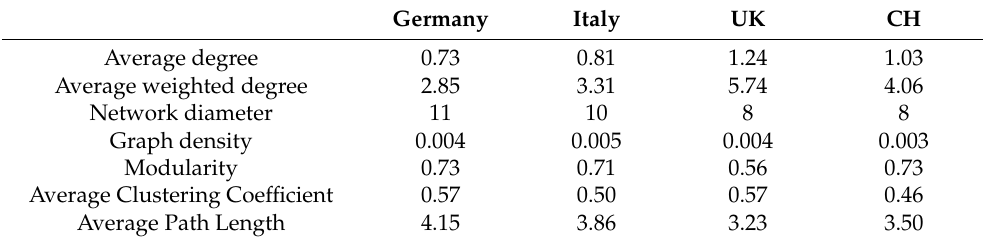
Table 2. Summary of Network Measures.